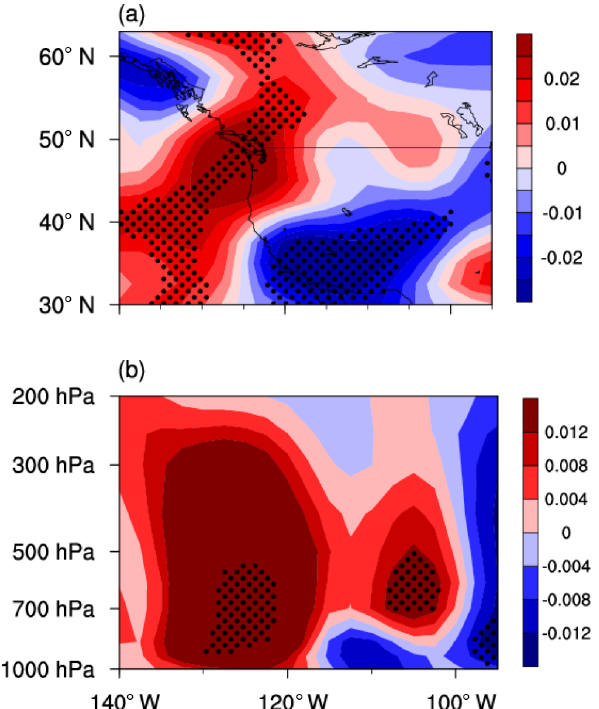
Figure 5. (a) Longitude–latitude cross section of differences in composite April vertical velocity anomalies (averaged over 1000– 500hPa) between positive and negative ASO anomaly events for 1984–2016. (b) Longitude–height cross section of differences in composite April vertical velocity anomalies (averaged over 43– 50 ◦ N) between positive and negative ASO anomaly events from 1984 to 2016. Blue is upward motion, and red is downward mo- tion. Dots denote significance at the 95% confidence level. Before performing the analysis, the seasonal cycle and linear trend were removed from the original dataset. The ASO anomaly events are selected based on Table 2. The vertical velocity (Pas − 1 ) dataset is from NCEP-2.